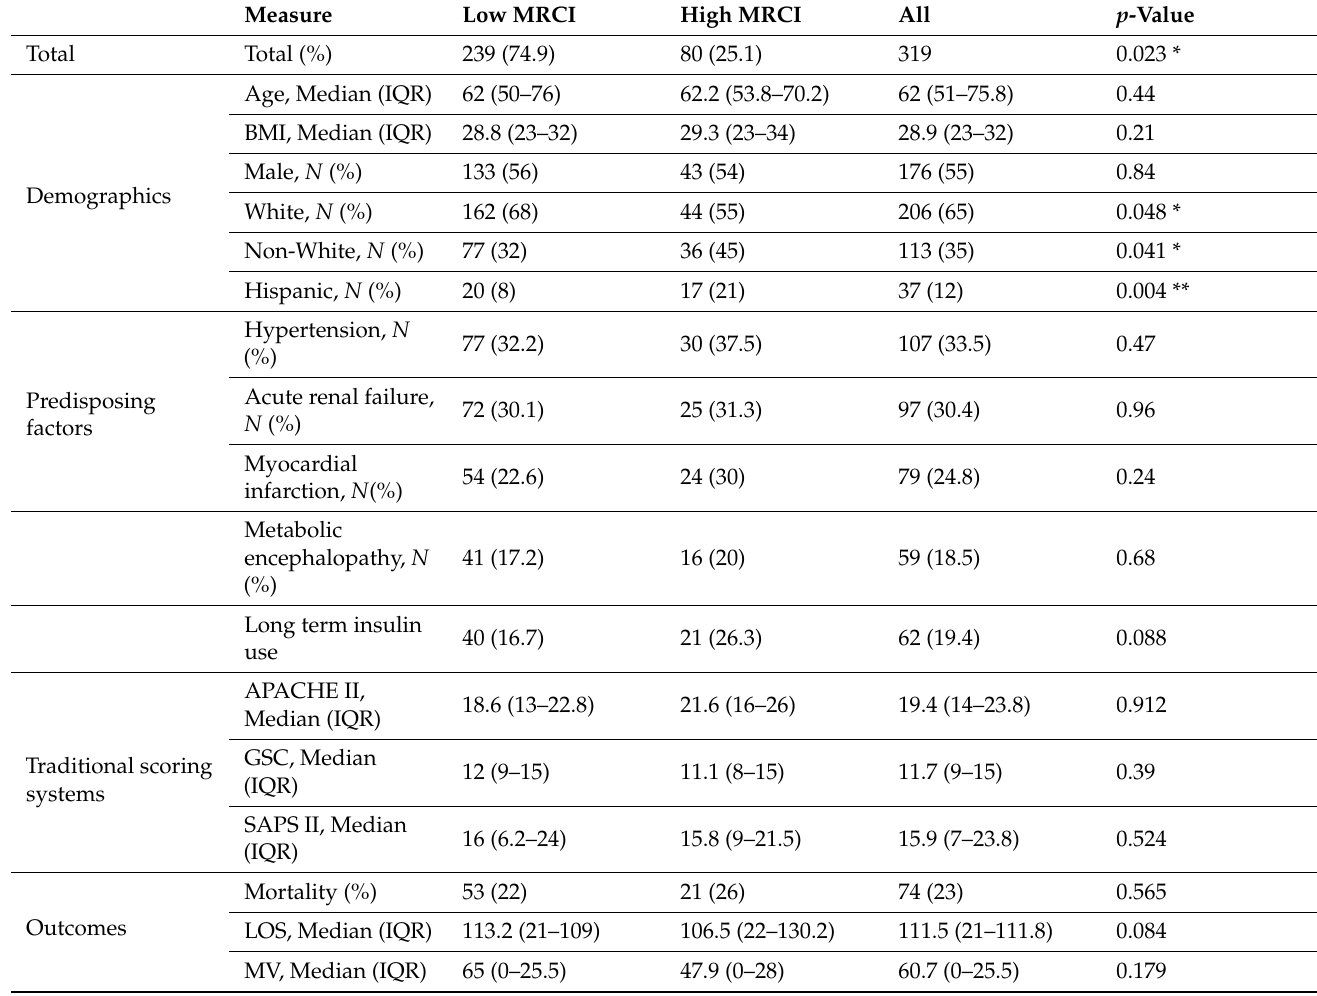
Table 1. Demographic characteristics of low and high MRCI groups.